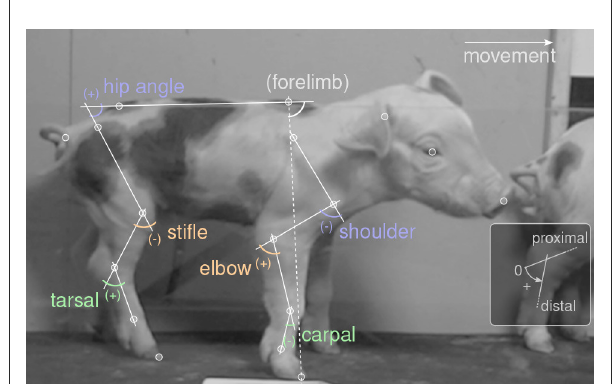
FIGURE1 Video digitization and joint angle definitions. White circles mark points of interest (“landmarks”). Movement was always rightwards. Labels show joint angles, defined as shown in the inset: straight joint (parallel segments) corresponds to zero; counter-clockwise angles are positive. Forelimb angle was used as a reference for temporal alignment, but did not enter the